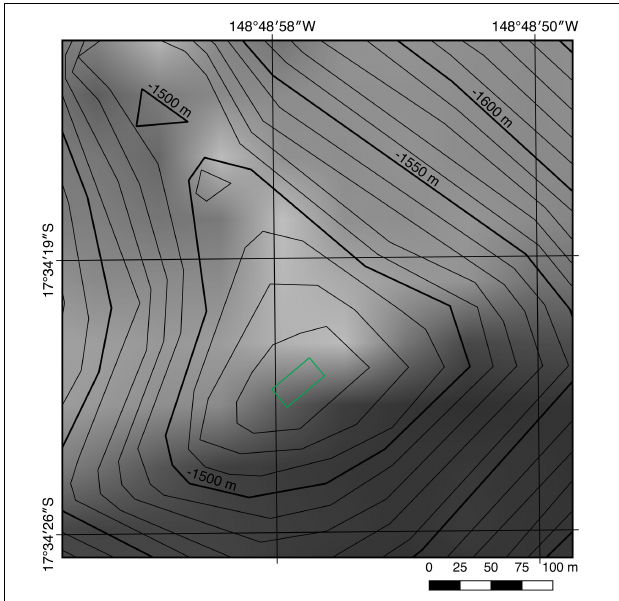
FIGURE 8 | Detailed bathymetric map (10 m contours) for the summit of the TH1 cone at Teahitia seamount (see Figure 3 ). Green rectangle illustrates a projected area of ∼ 40 × 20 m for the upper 4–5 m of the cone where low-temperature venting had previously been noted to be concentrated (Hékinian,